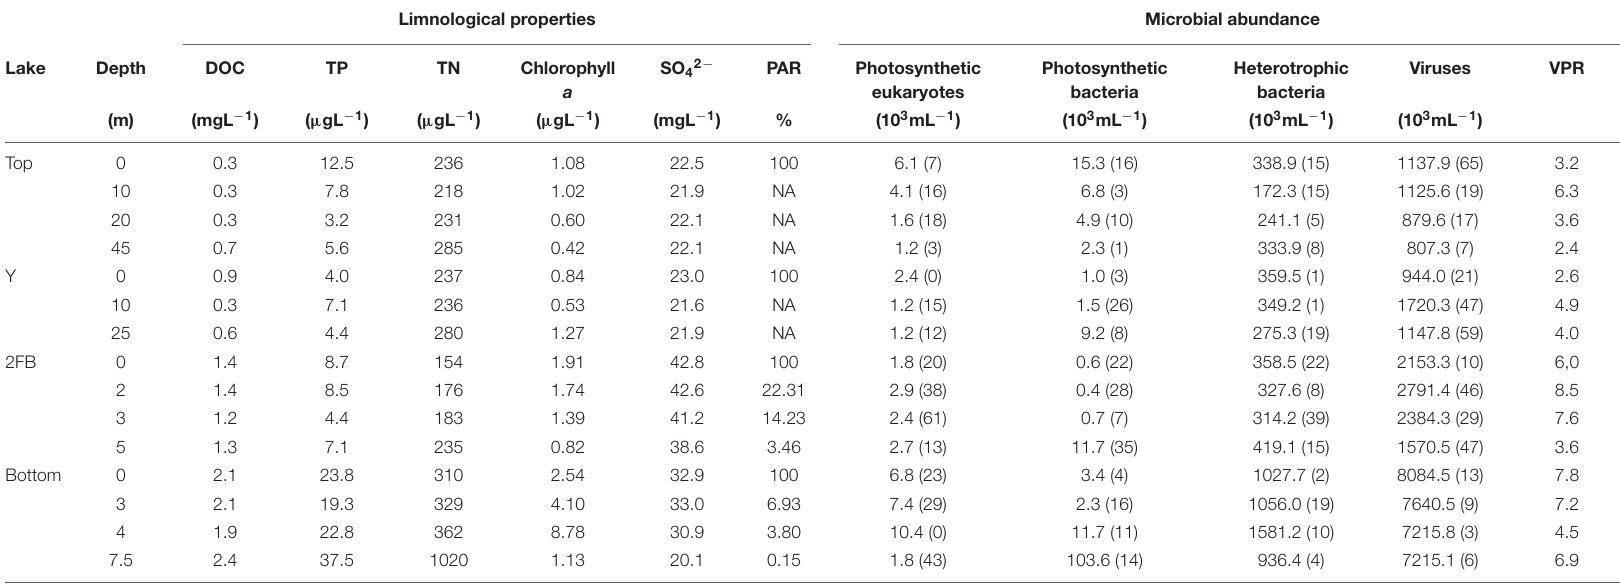
TABLE 1 | Limnological characteristics of sampled depths for each studied